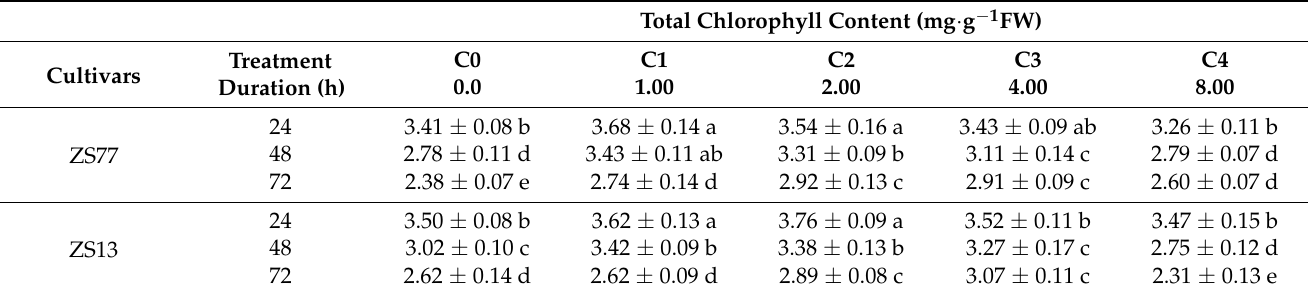
Table 1. Effects of exogenous SA on total chlorophyll content of sweet potato under drought